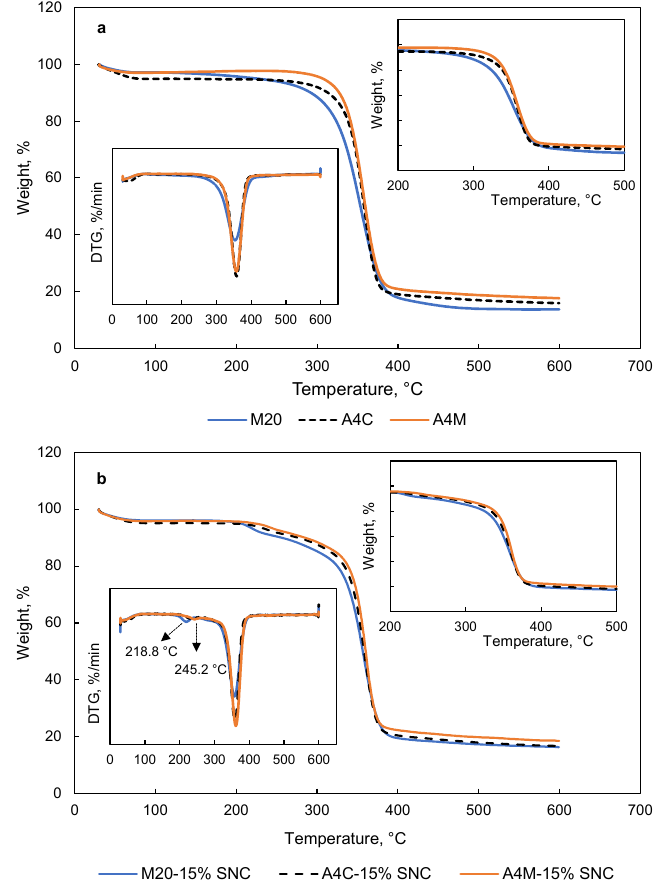
Figure 6. TGA and DTG curves of ( a ) MC films and ( b ) MC-SNC nanocomposite films. Table 2. Thermal properties of MC films and MC nanocomposite films.